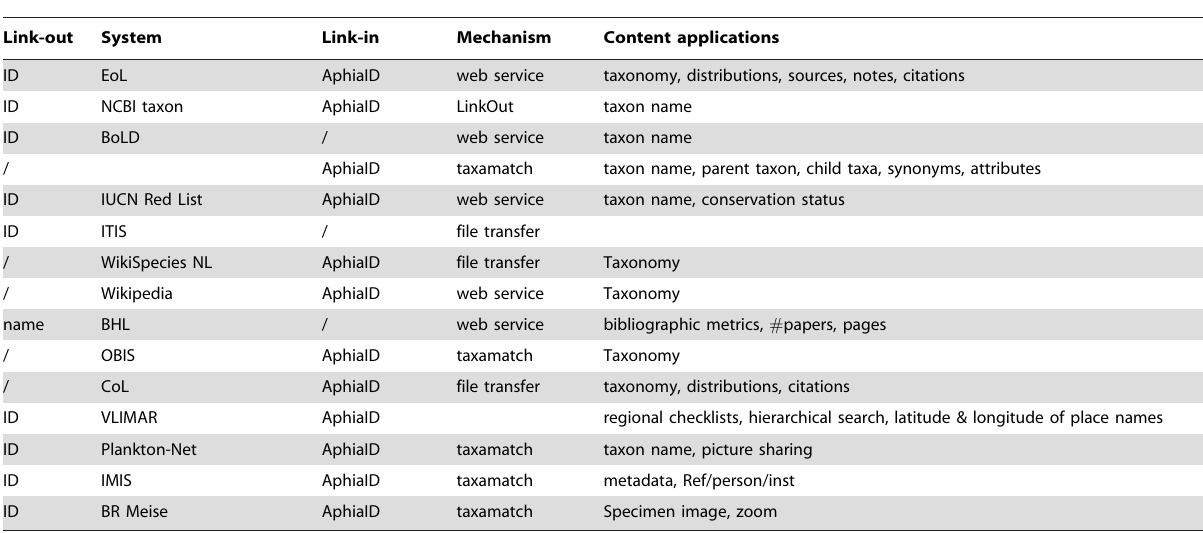
Table 7. Examples of how WoRMS links with other online biodiversity resources.